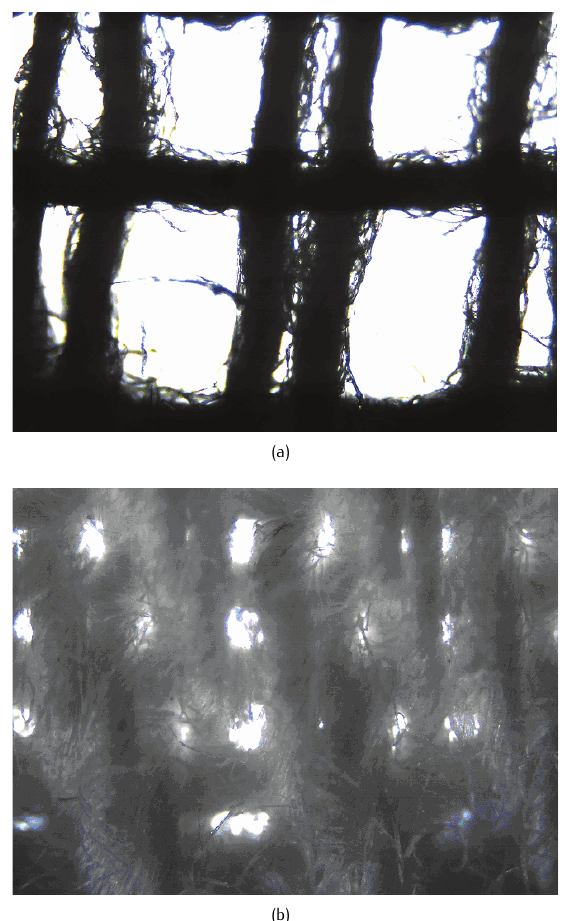
Figure 3. Digital images of Sample 2 (a) and Sample 14 (b), taken under 4x enlargement